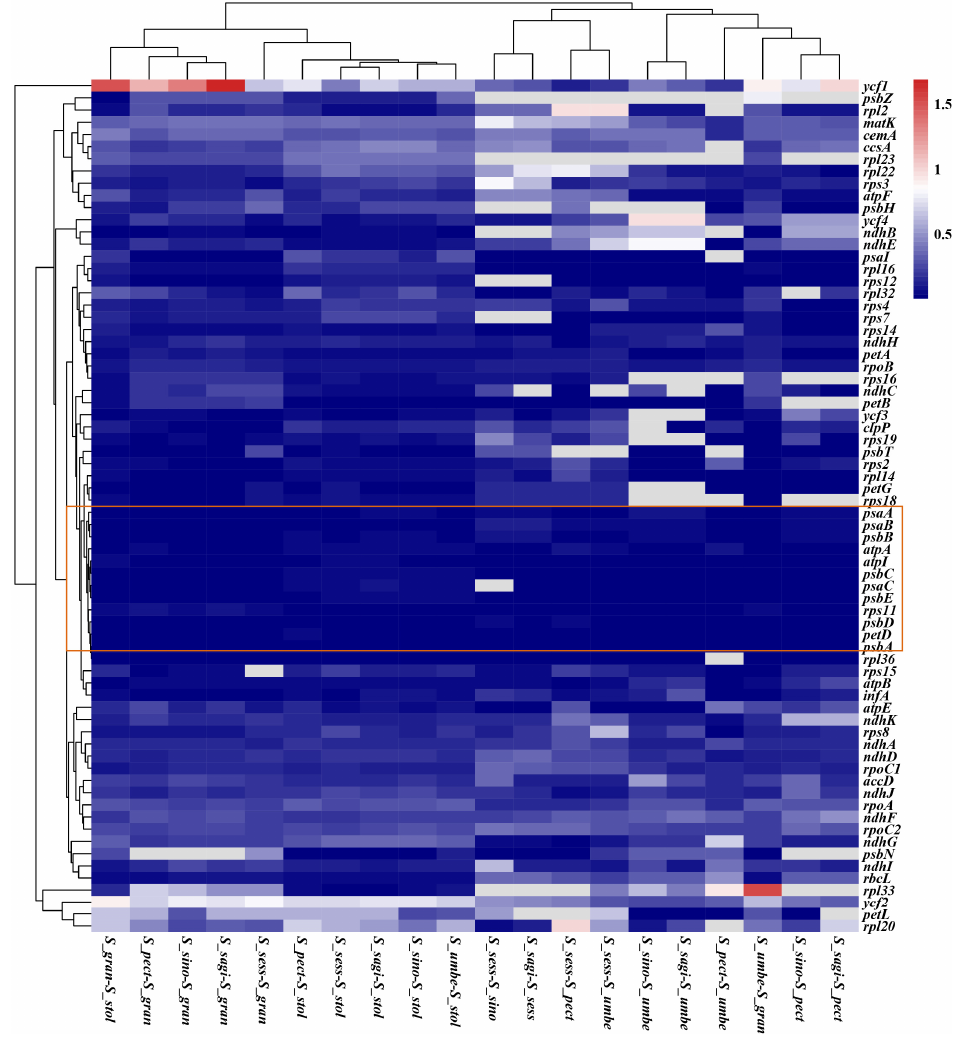
Figure 8. Heatmap representing pairwise Ka/Ks ratios of PCGs among Saxifraga species. The color bias toward red indicates that there is a higher Ka/Ks ratio between